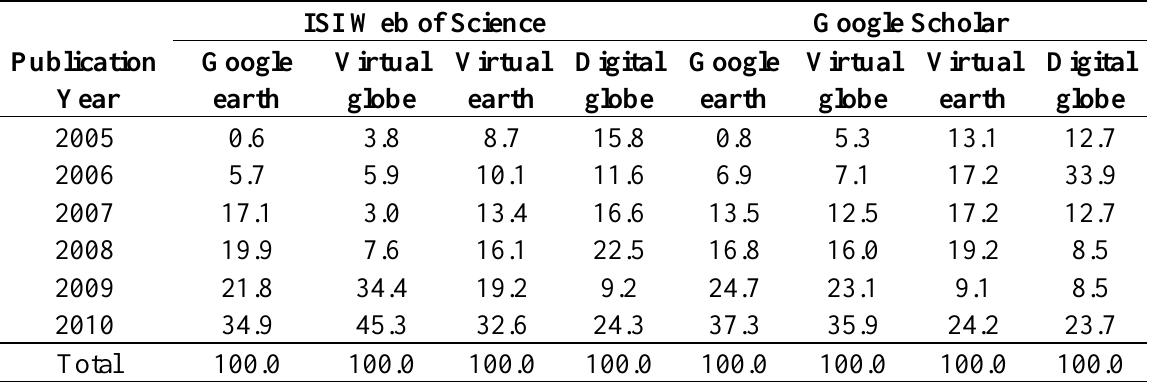
Table 1. Number of citations for the key terms used in this article. (a) Total number of